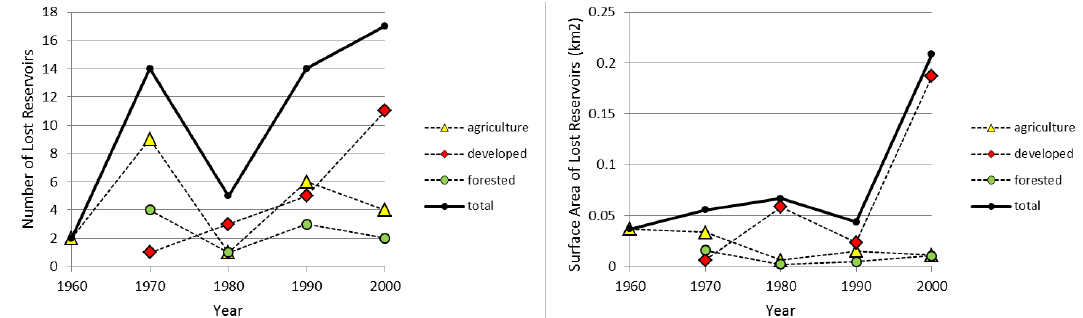
Figure 7. Number and acreage of small reservoirs abandoned during prior decade in urban developed watersheds from 1960 to 2000 (only one reservoir was abandoned in other study watersheds). Reservoirs are classified by adjacent land cover immediately prior to abandonment.